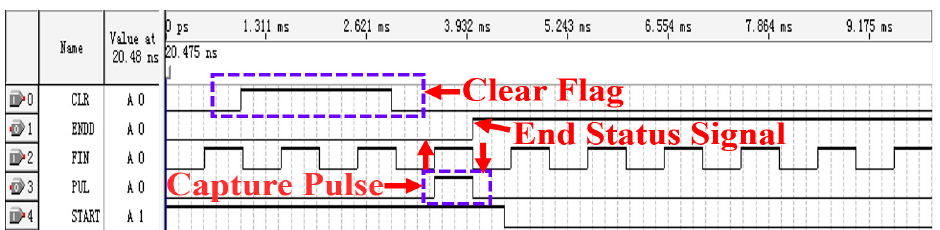
Figure 10. Pulse width measurement and duty cycle measurement.